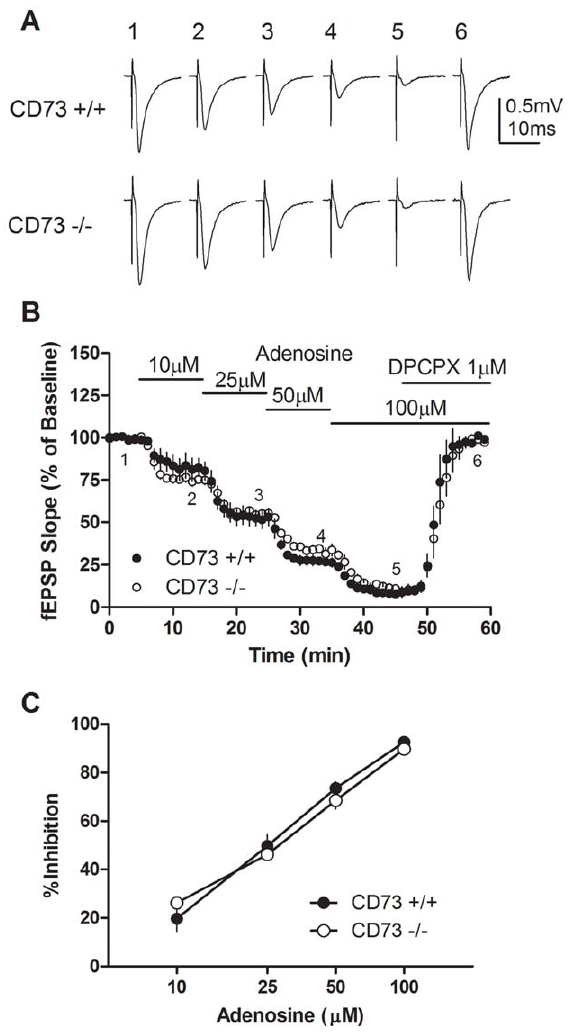
Figure 2. Inhibition by adenosine of fEPSP recordings in hippocampal slices from CD73 + / + and CD73 2 / 2 mice. (a) Representative traces of fEPSPs; numbers 1–6 correspond to before and during superfusion of slices with adenosine (10, 25, 50 or 100 m M) or adenosine (100 m M) and DPCPX (1 m M) as indicated in (b). (b) The effect of adenosine on fEPSP slope in hippocampal slices from CD73 + / + and CD73 2 / 2 mice. Horizontal lines represent the duration of superfusion with the indicated adenosine concentrations. (c) Maximum inhibition of fEPSPs obtained with each concentration of adenosine. n =3 CD73 + / + and 3 CD73 2 / 2